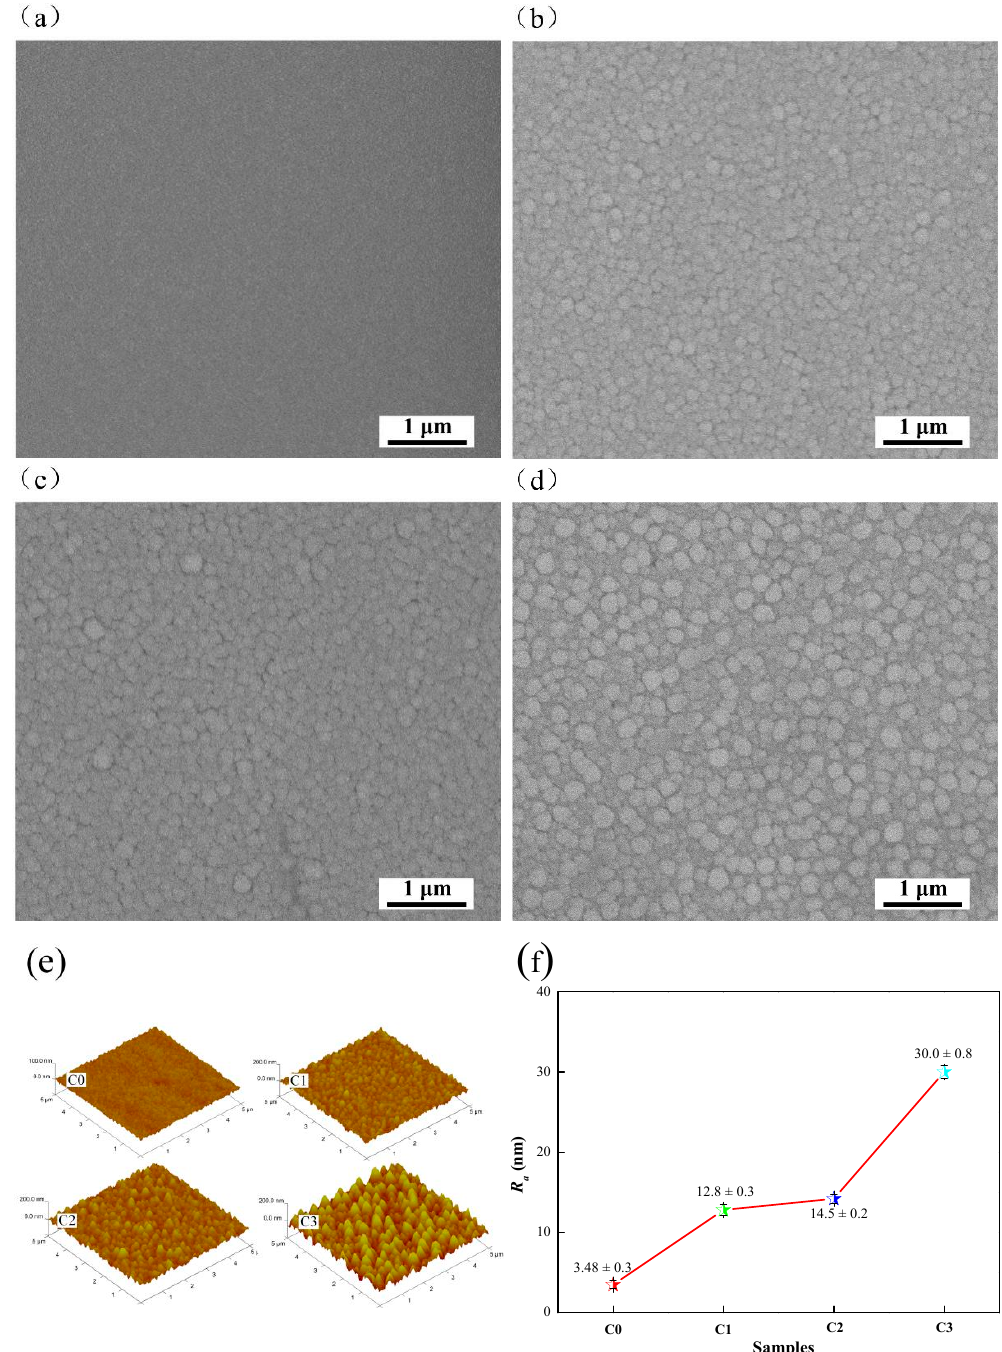
Figure 4. Scanning electron microscope (SEM) images: ( a ) C0, ( b ) C1, ( c ) C2 and ( d ) C3. ( e ) Atomic force microscope (AFM) images and ( f ) surface roughness.